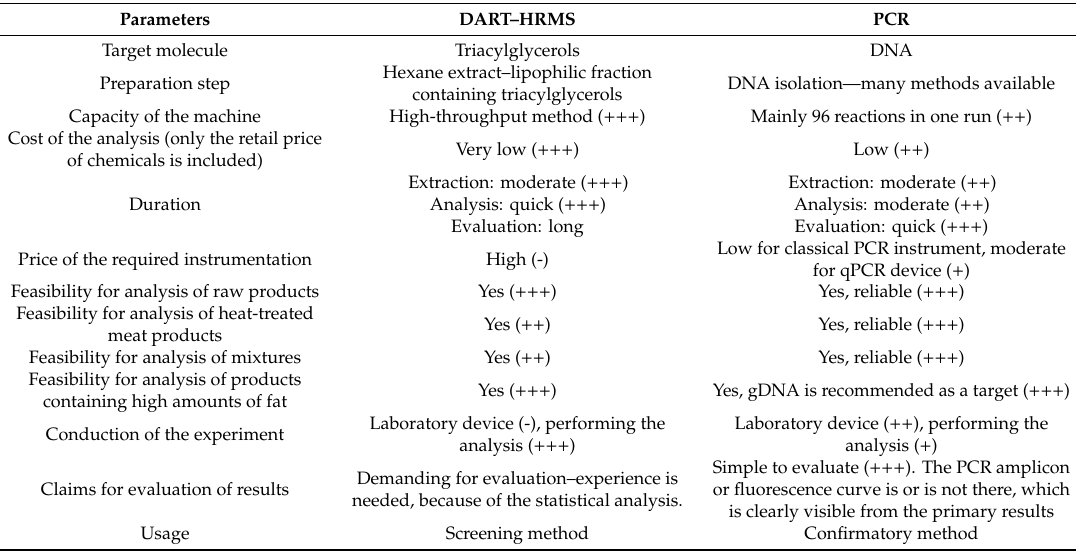
Table 5. Comparison of DART–HRMS and